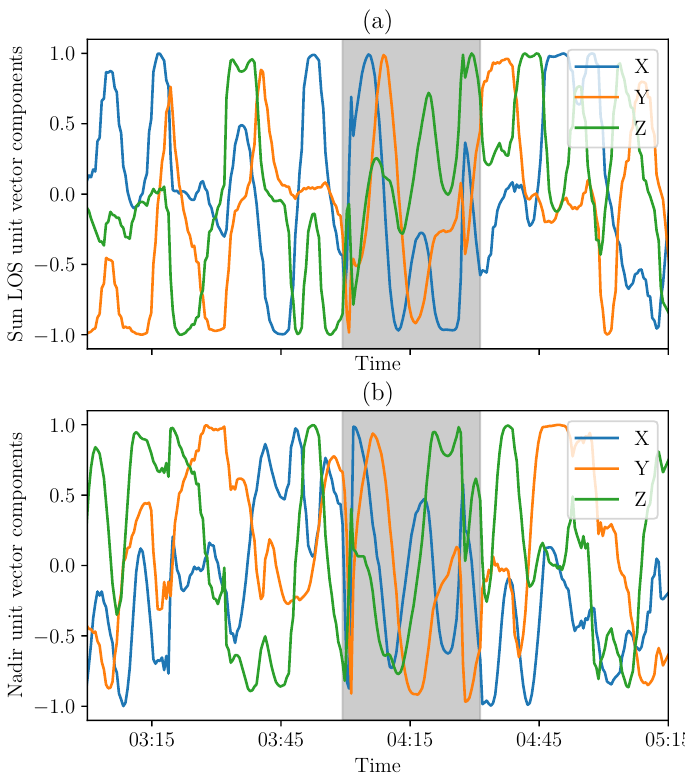
Figure 9. First lights of the Sun LOS ( a ) and nadir ( b ) components in the satellite body frame based on MEKF on 2 March 2021 (representative period in the case of measurements at 30 s intervals almost continuously with eclipse phase in